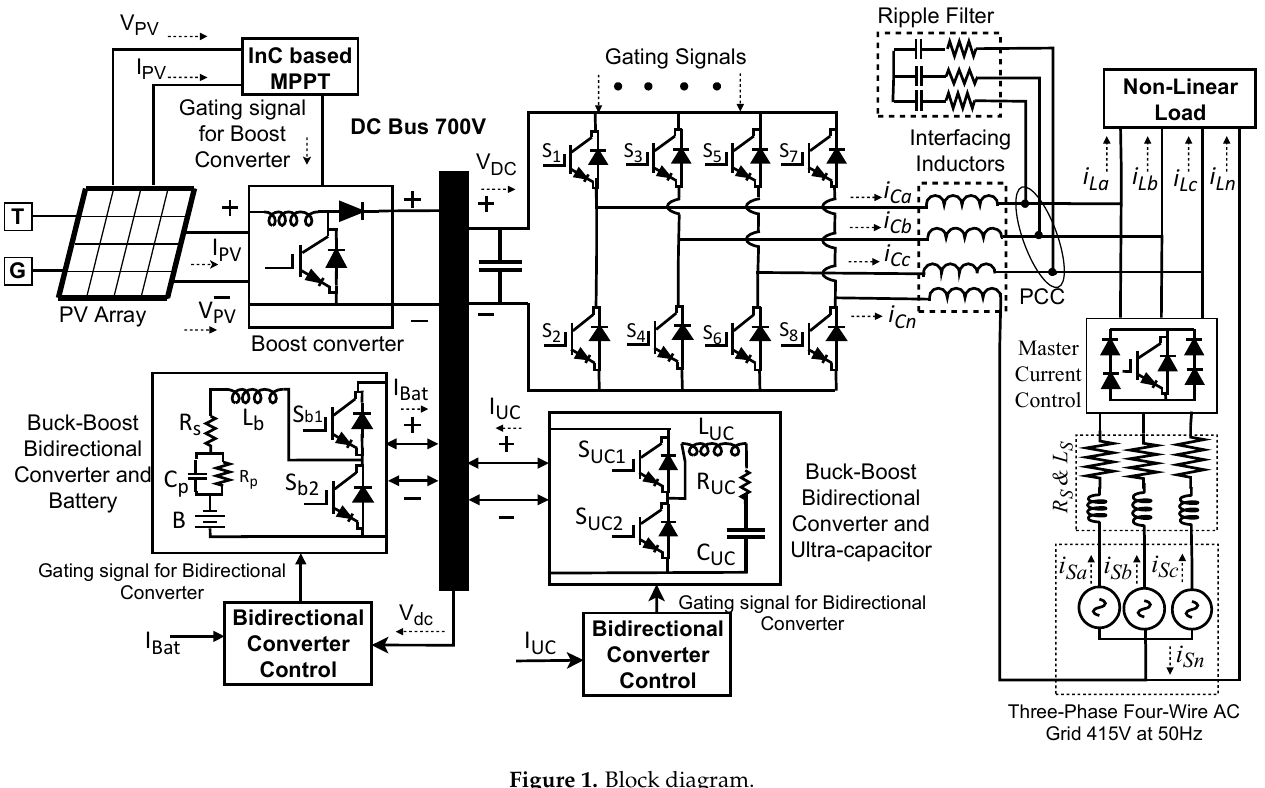
Figure 1. Block diagram.